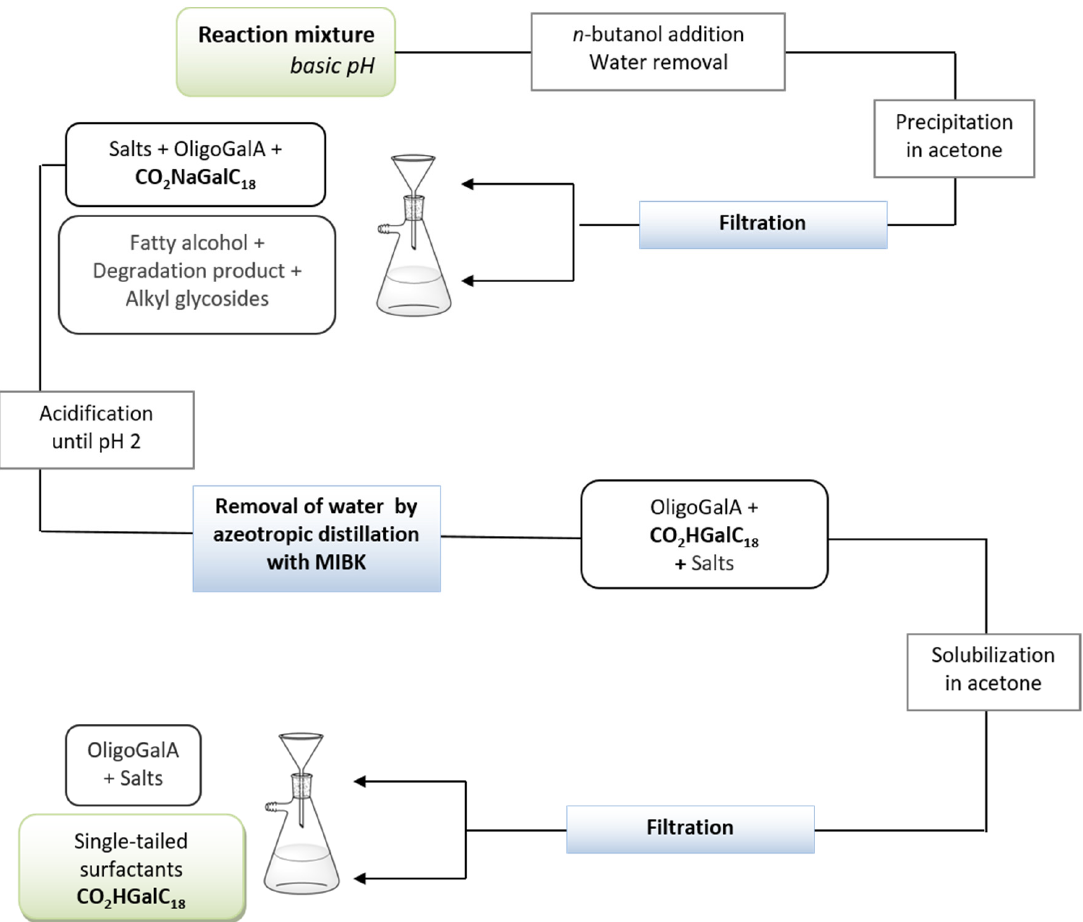
Figure 5. Procedure based on successive filtrations for the isolation of purified n -oleyl D -galacto- siduronic acids CO 2 HGalC 18 .